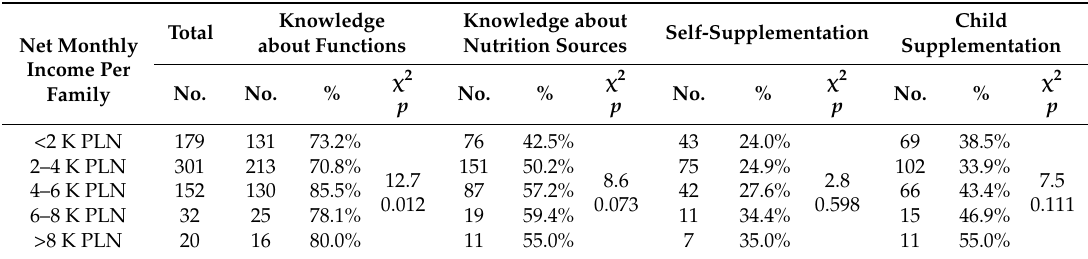
Table 7. The influence of net income per family on knowledge and supplementation of vitamin D ( n = 684) ( p =